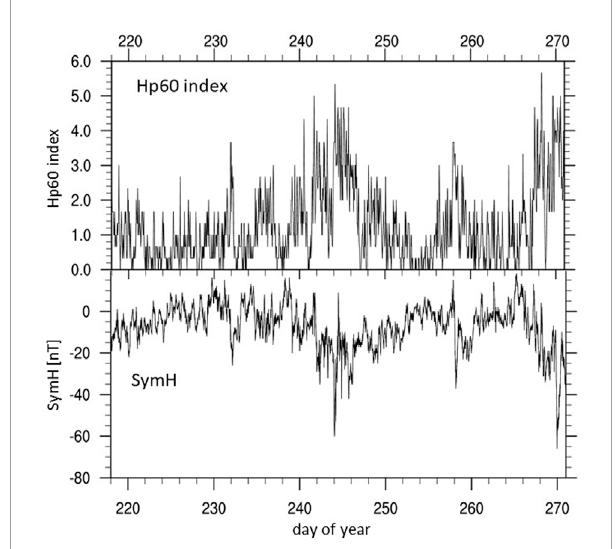
FIGURE 1 Geophysical conditions from August 5 (DOY 218) to September 26 (DOY 270) 2020: Hp60 index (top) and Sym/H [nT] (bottom).